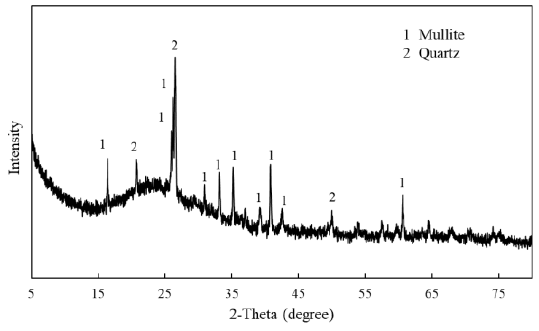
Figure 1. The XRD pattern of coal fly